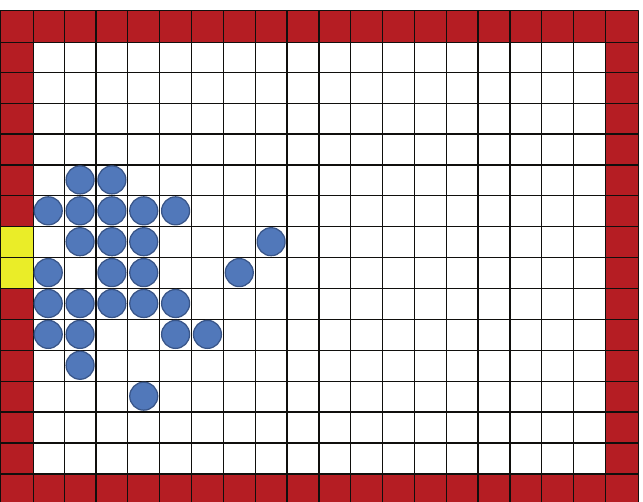
Figure 6: Snapshot of a simulation for the floor field in Figure 5 with N (cid:8) 150 occupants after 65 time steps.